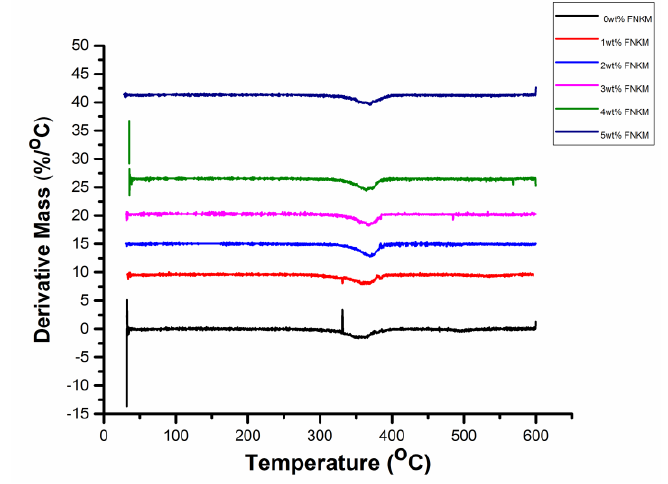
Figure 5. Differential thermal gravimetric (DTG) curves of 0–5 wt % loaded FNKM in CA membranes.